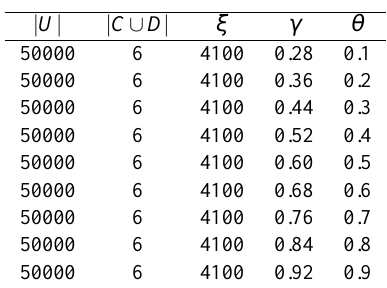
Table 6. Characteristics of artificial data sets used for experi- ments, 2 groups of data sets